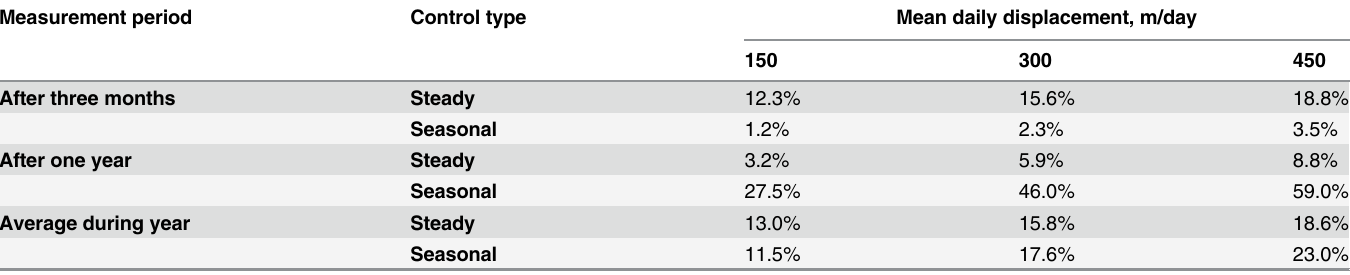
Table 3. Effect of mobility of tsetse on the population remaining after various periods of seasonal and steady control with sustained invasion pressure. Measurement